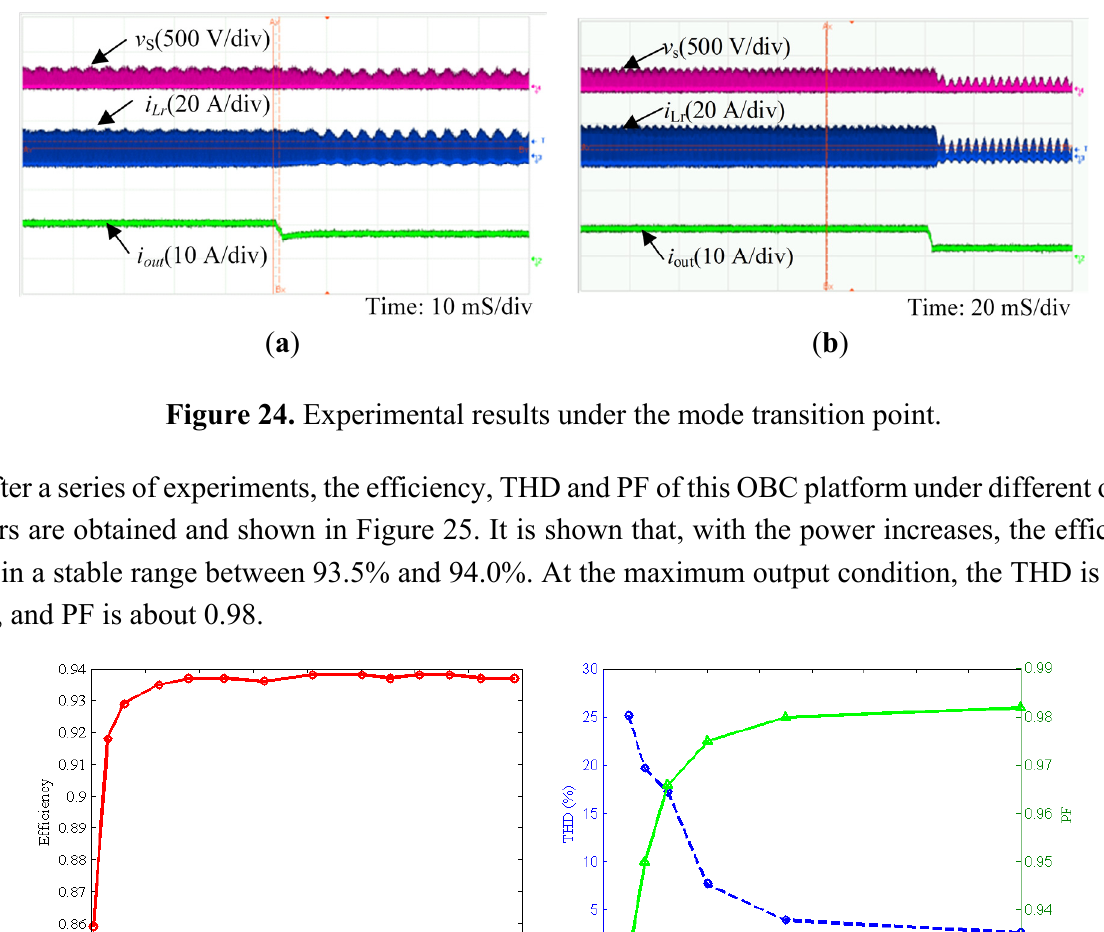
Figure 23. Experiment results under the floating voltage charging stage.